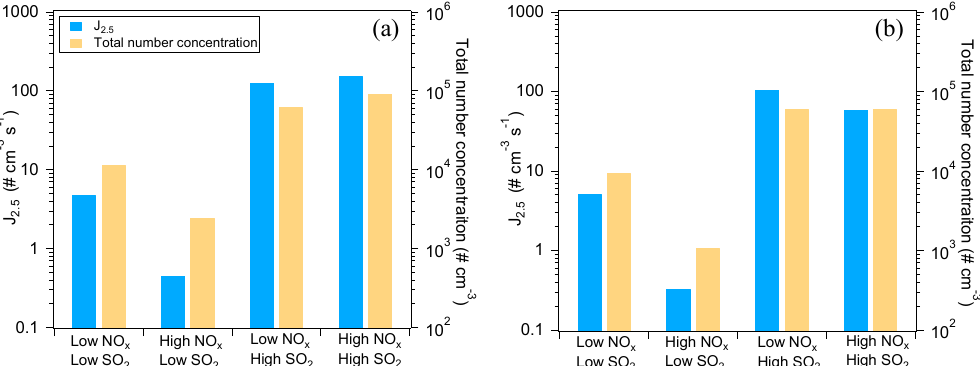
Figure 2. Nucleation rates ( J 2 . 5 ) and maximum total particle number concentrations under different NO x and SO 2 conditions for the SOA from α -pinene oxidation (a) and from limonene oxidation (b)